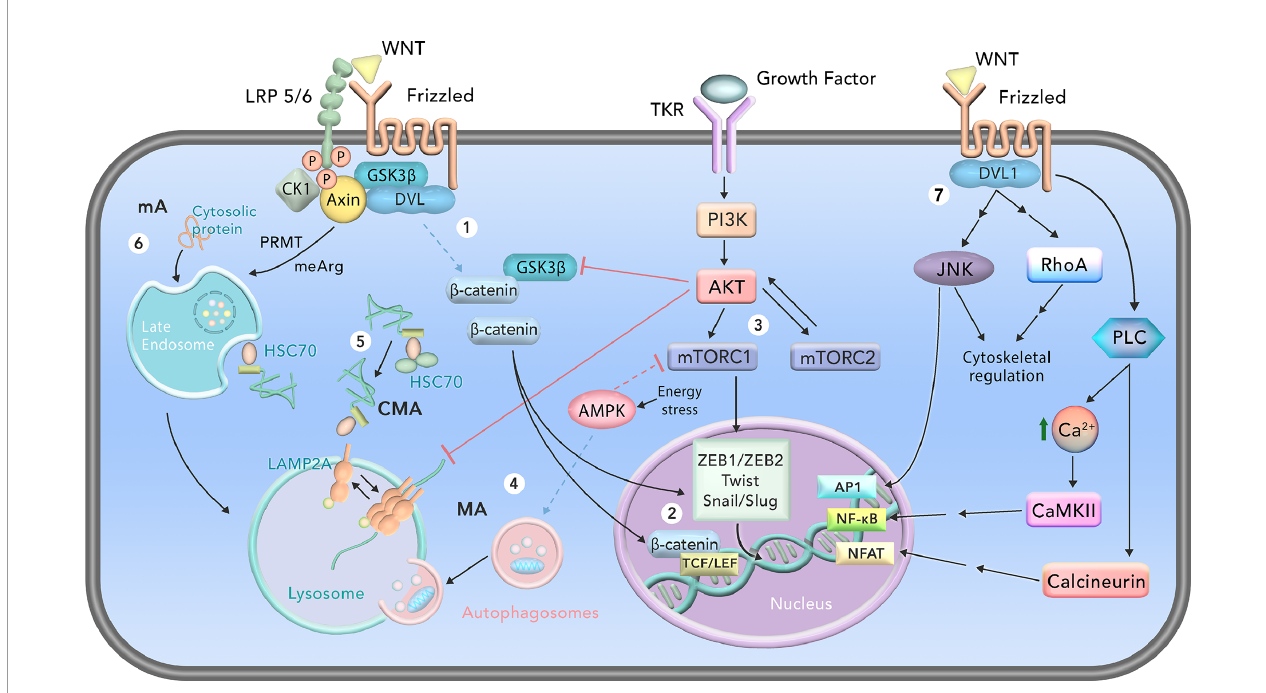
FIGURE 1 | Schematic representation of cell signaling pathways involved in autophagy and epithelial-mesenchymal-transition (EMT). 1) In the canonical WNT signaling, b -catenin stabilizes and translocates to the nucleus after binding of WNT to Frizzled and low-density lipoprotein receptor-related protein 5/6 (LRP5/6) receptors. GSK3 is sequestered together with proteins of the destruction complex of b -catenin (DVL, axin, CK1). 2) In the nucleus, b -catenin binds to TCF/LEF transcriptional factors, activating its target genes. b -catenin also stimulates transcription of important EMT transcriptional factors such as ZEB1/ZEB2, Twist and Snail/Slug. 3) EMT is also induced by the mammalian Target of Rapamycin Complex 1 (mTORC1) signaling, through activation of the transcriptional factors ZEB1/ ZEB2, Twist and Snail/Slug. mTORC1 and mTORC2 are activated by tyrosine kinase receptor (TKR) signaling through PI3K/AKT. mTORC2 also stimulates AKT. 4) Depending on the energy status of the cell, activation of AMP Kinase (AMPK) inhibits mTORC1 and induces macroautophagy (MA). 5) Chaperone-mediated autophagy (CMA) degrades cytosolic proteins that possess the KFERQ or KFERQ-like motif through recognition and binding of the heat shock-cognate chaperone of 71 kDa (HSC70) and a cochaperone complex. HSC70 targets the substrate protein to the lysosomal membrane, where it binds monomeric lysosome-associated membrane protein type 2A (LAMP2A) and induces its multimerization and stabilization. The substrate protein is unfolded and translocated into the lysosome for degradation through multimerized LAMP2A. 6) In mammals, microautophagy (mA) occurs in the late endosome, in a process called endosomal microautophagy. It can degrade cytosolic proteins, and some are recognized by HSC70. Some proteins, such as GSK3, are targeted for mA through arginine methylation (meArg) by protein arginine methyltransferases (PRMTs). After entering the late endosome, this organelle fuses with lysosomes to complete the mA cycle. 7) In the noncanonical WNT signaling, WNTs bind to Frizzled receptors and DVL1 is recruited to the membrane. c-Jun N-terminal kinases (JNKs), RhoA and phosphoinositide phospholipase C (PLC) can be activated by noncanonical WNT. JNK and RhoA further regulate the cytoskeleton, and JNK induces gene transcription through activator protein 1 (AP1). PLC increases cytosolic Ca 2+ levels, leading to activation of Ca 2+ /calmodulin-dependent protein kinase II (CAM-KII) and calcineurin, which activate nuclear factor kappa-light-chain-enhancer of activated B cells (NF- k B) and nuclear factor of activated T cells (NFAT), respectively. Solid black lines represent activation, while solid red lines represent inhibition. Double black lines represent indirect activation. Dashed lines indicate protein interactions when the WNT/ b - catenin and mTOR signaling are not